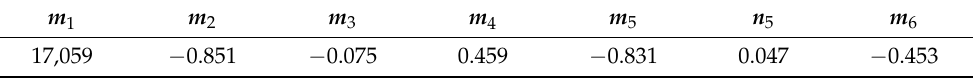
Table 6. Fitting parameters for the dimensionless model of cuttings bed